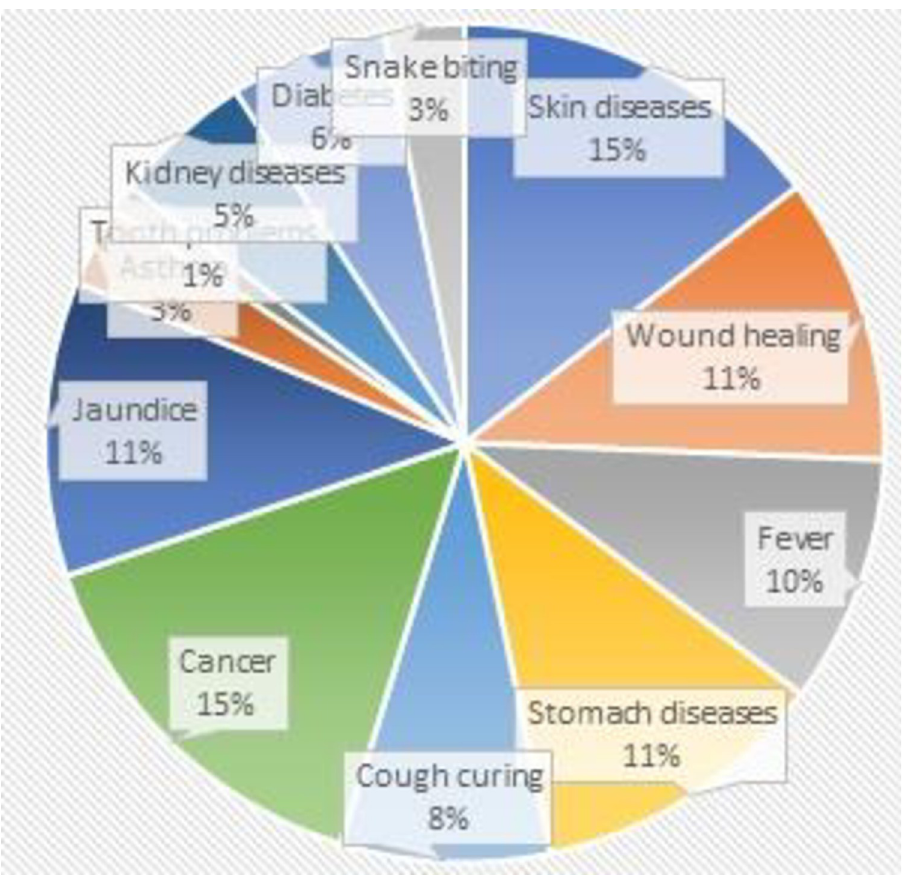
Fig 2. Ethnomedicinal uses of herbs of Shiwalik Mountain Range of District Bhimber of AJK Pakistan.